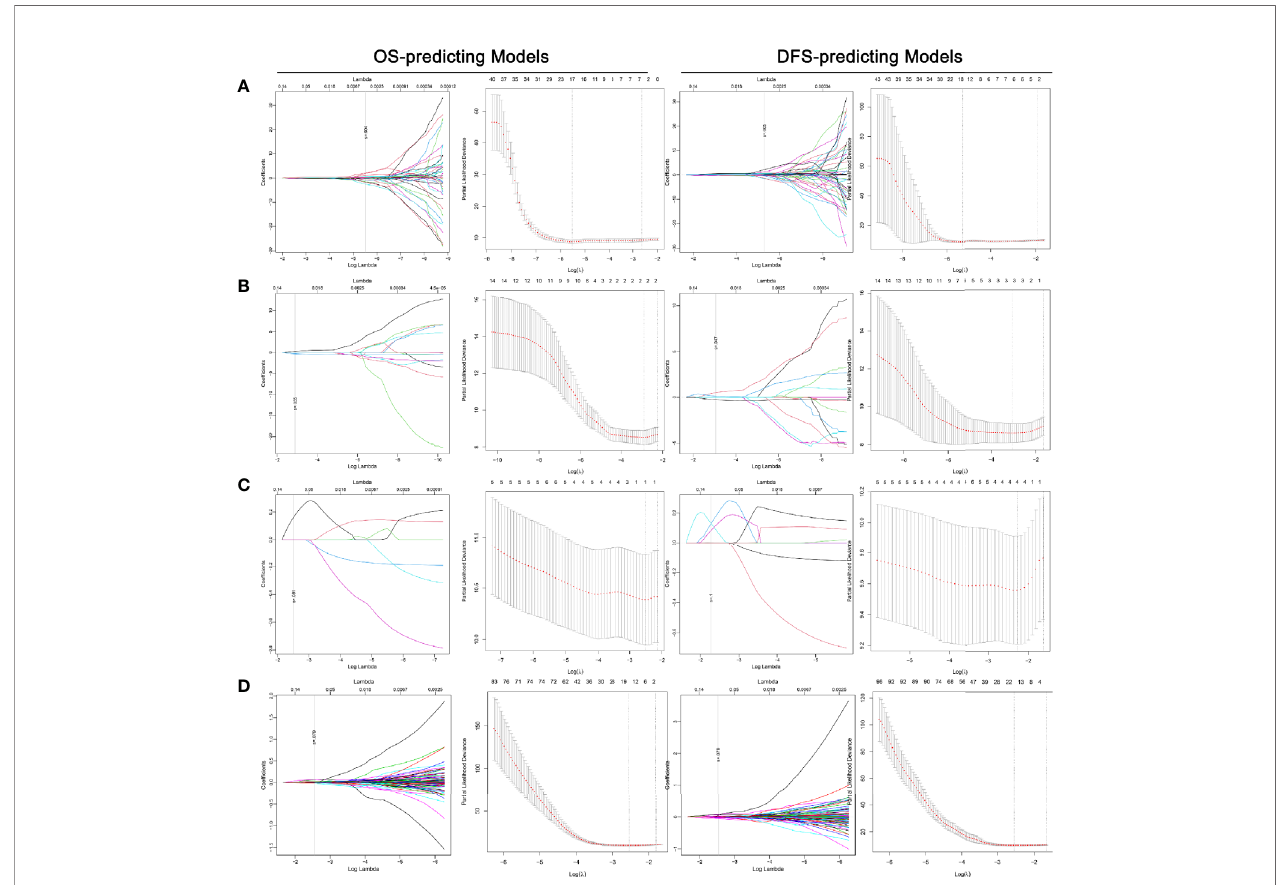
FIGURE 4 | LASSO COX regression for the OS- and DFS-predicting models based on radiomics features extracted from nephrographic (A) , corticomedullary (B) and unenhanced (C) phase and transcriptome mRNA level (D). Left plot of each model: The dotted vertical line was plotted at the value selected by the 10-fold cross-validation based on the minimum criteria (the value of lambda with the lowest partial likelihood deviance). Right plot of each model: Selection of the tuning parameter (lambda) in the LASSO regression via 10-fold cross-validation based on minimum criteria. LASSO: Least absolute shrinkage and selection operator; OS, Overall